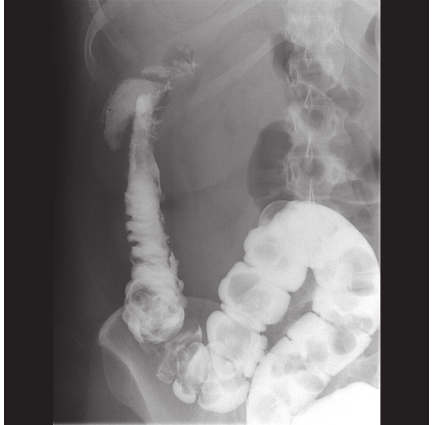
Figure 2: Gastrografin enema demonstrating stricture at splenic flexure region.